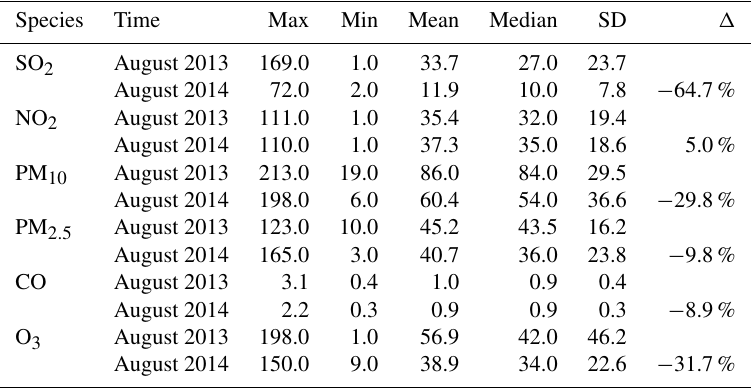
Table 2. Statistical analysis of hourly data in August 2013 and August 2014 at CCM station (the unit is µgm − 3 except CO (mgm − 3 )) . The change percentage of species ( (cid:49) ) in August 2014 is based on August 2013.